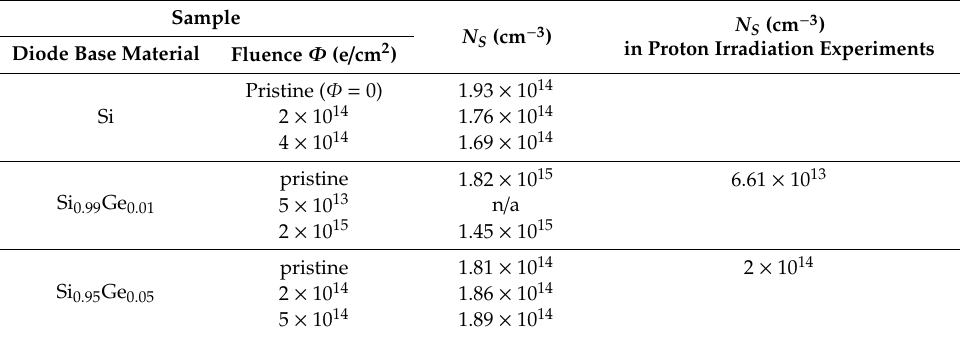
Table 2. The doping concentrations evaluated using C-V